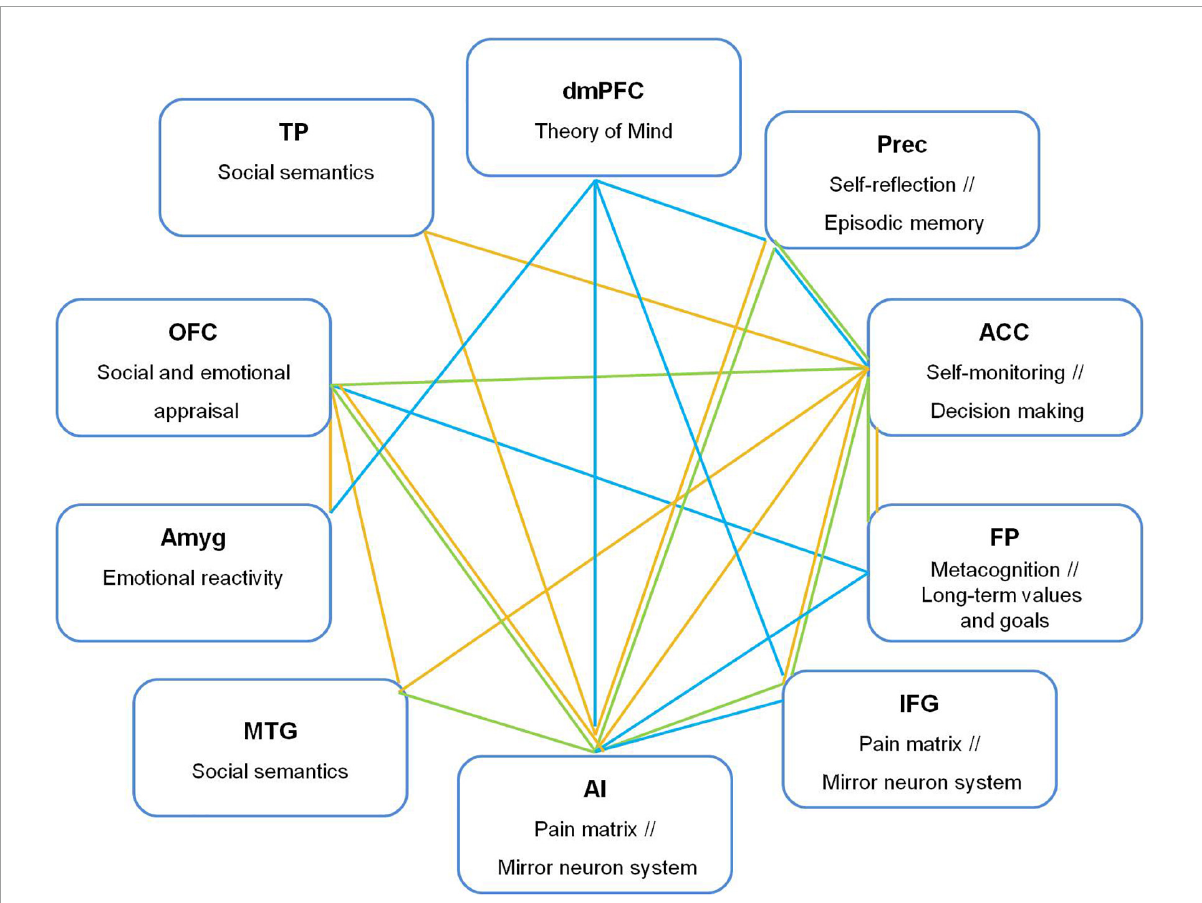
FIGURE3 Functional connections from dorsomedial prefrontal cortex (dmPFC), anterior cingulate cortex (ACC), orbitofrontal cortex (OFC), and anterior insula (AI) with brain regions related to empathic and moral processes underlying compassion. Prec, precuneus; FP, frontal pole; IFG, inferior frontal gyrus; TPJ, temporoparietal junction, Amyg, amygdala; OFC, orbitofrontal cortex; TP, temporal pole; MTG, middle temporal gyrus. Green line: Both-gender group; yellow line: Men, blue line: